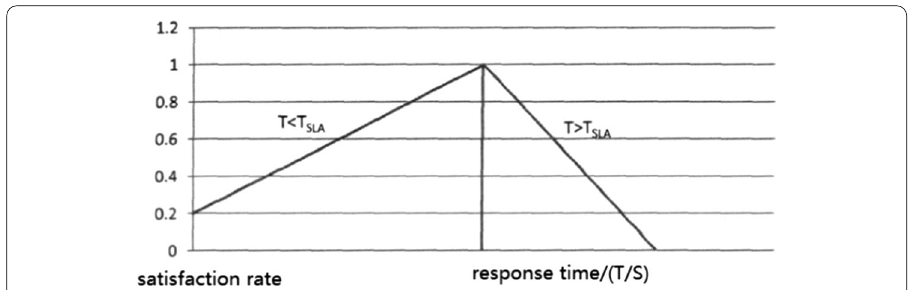
Fig. 1 SLA estimation model for cloud computing engineering